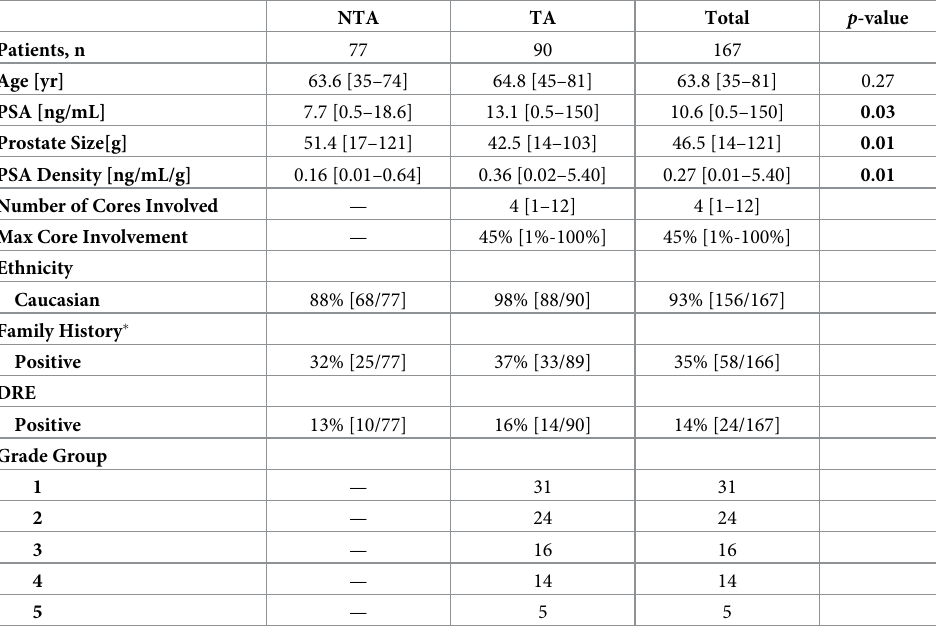
Table 1. Urine sample clinical and pathologic